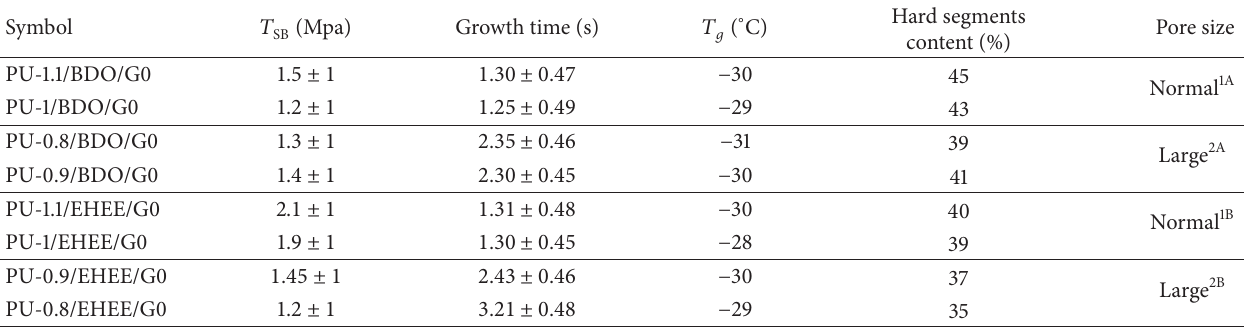
Table 2: Characteristics of unmodified PU foams.